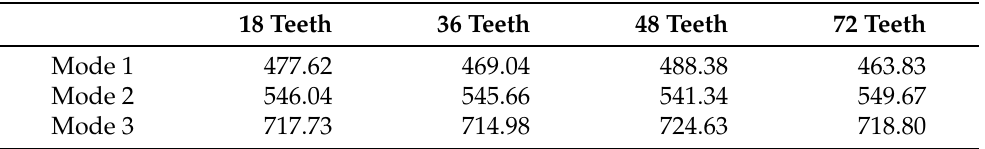
Table 3. Comparison of the first three natural frequencies (in Hz) of the stators with different numbers of teeth.